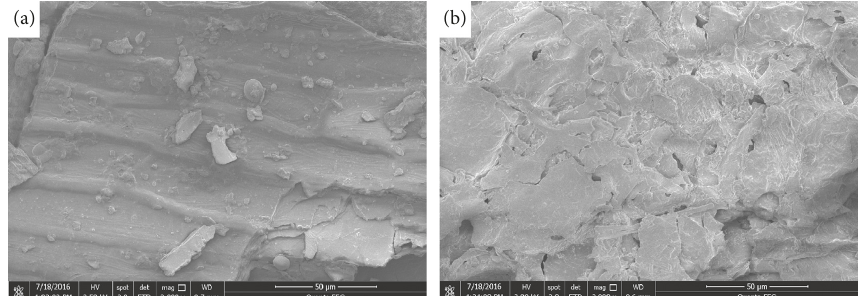
Figure 1: Scanning electron microscopic images of the surface structure of wheat bran: (a) unfermented wheat bran and (b) fermented wheat